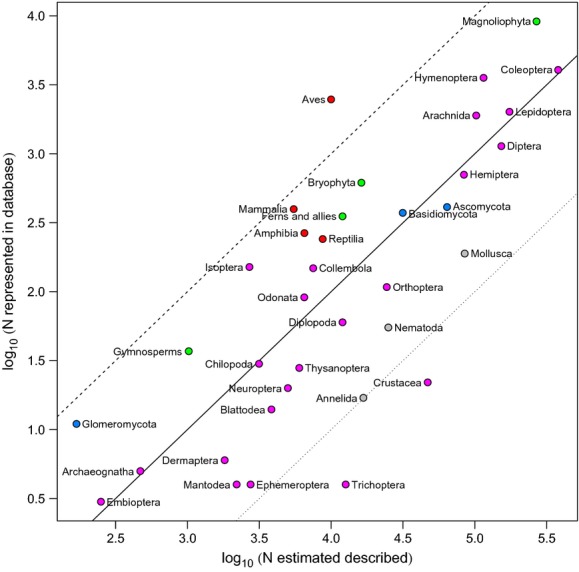
Taxonomic coverage. The number of species in our database against the number of described species as estimated by Chapman (2009). Vertebrates are shown in red, arthropods in pink, other animals in gray, plants in green and fungi in blue. The dashed, solid and dotted lines indicate 10, 1 and 0.1% representation, respectively. Groups with just a single species in the database – Diplura, Mycetozoa, Onychophora, Pauropoda, Phasmida, Siphonaptera, Symphyla and Zoraptera – are not shown.